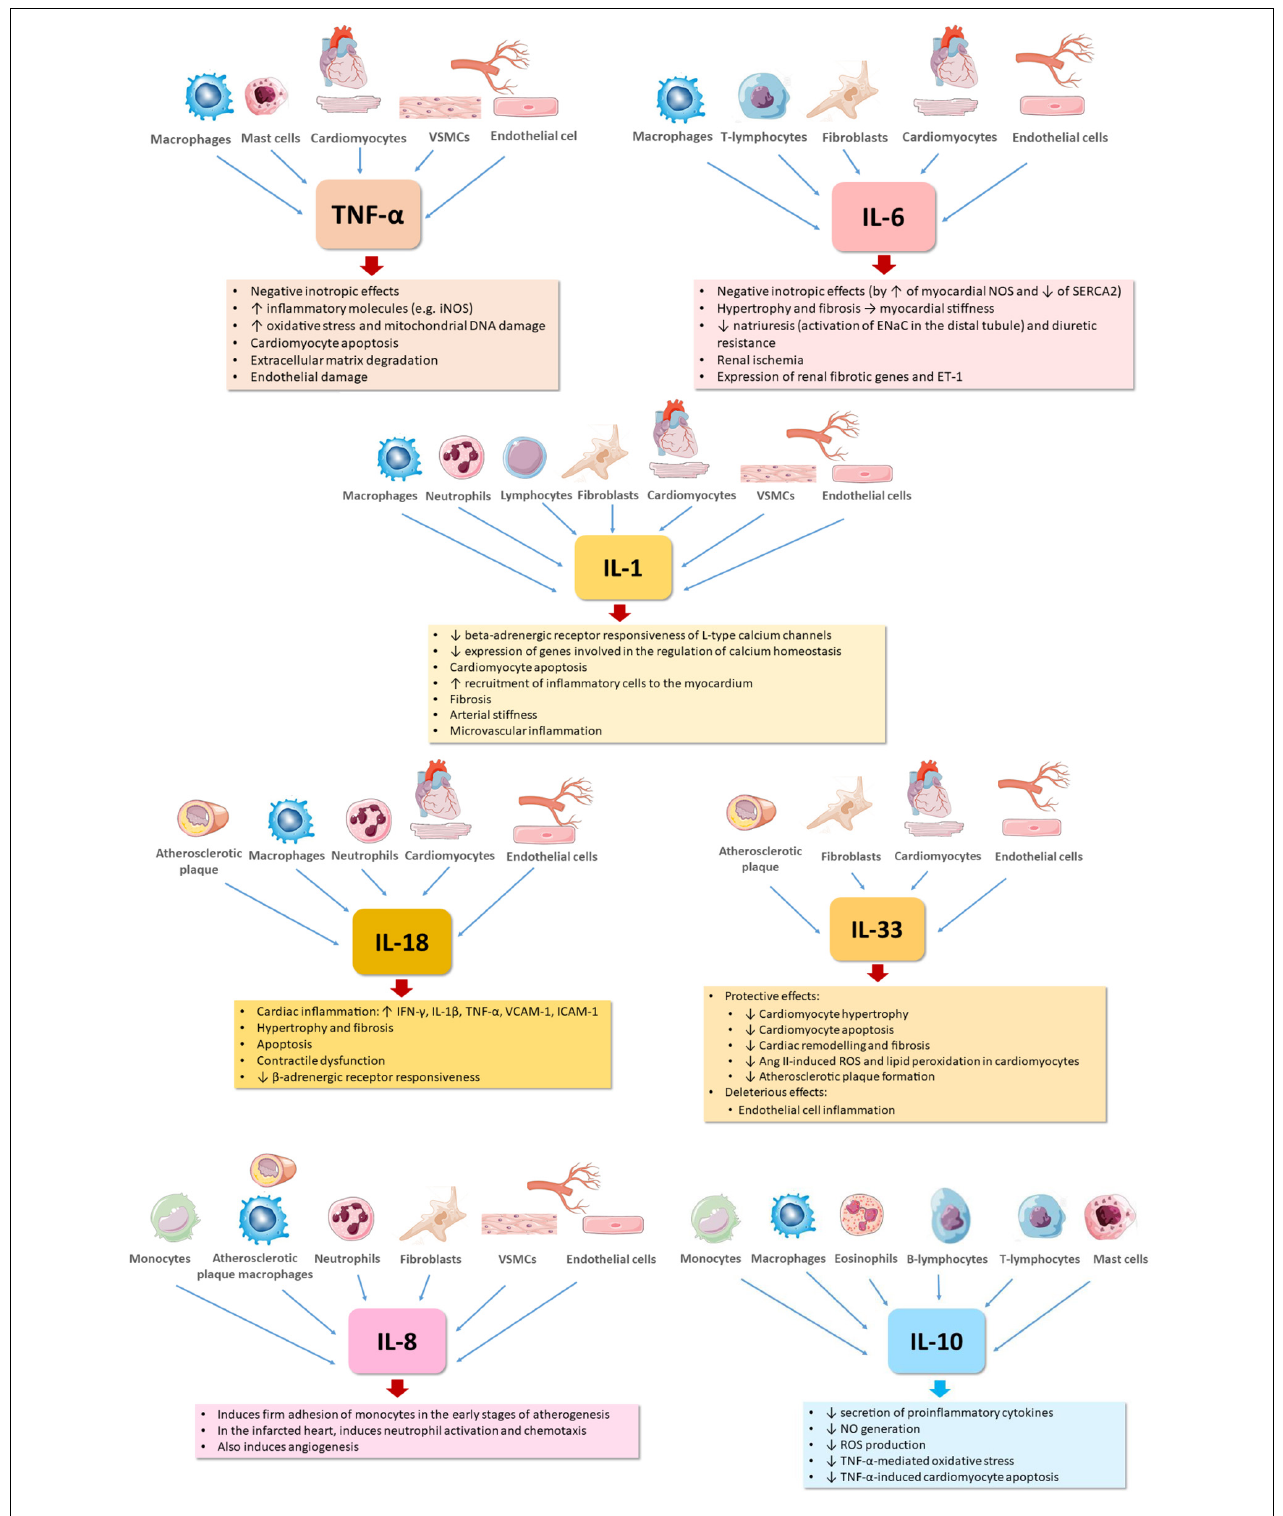
FIGURE 1 | Effects of major cytokines contributing to heart failure pathophysiology. DNA, deoxyribonucleic acid; ENaC, epithelial sodium channel; ET-1, endothelin-1; ICAM-1, intercellular adhesion molecule 1; IFN- γ , interferon gamma; IL-1, interleukin 1; IL-1 β , interleukin 1 beta; IL-6, interleukin 6; IL-8, interleukin 8; IL-10, interleukin 10; IL-18, interleukin 18; IL-33, interleukin 33; NO, nitric oxide; NOS, nitric oxide synthase; iNOS, inducible nitric oxide synthase; ROS, reactive oxygen species; SERCA2, sarcoplasmic/endoplasmic reticulum calcium ATPase 2; TNF- α , tumor necrosis factor alpha; VCAM-1, vascular cell adhesion molecule 1; VSMCs, vascular smooth muscle